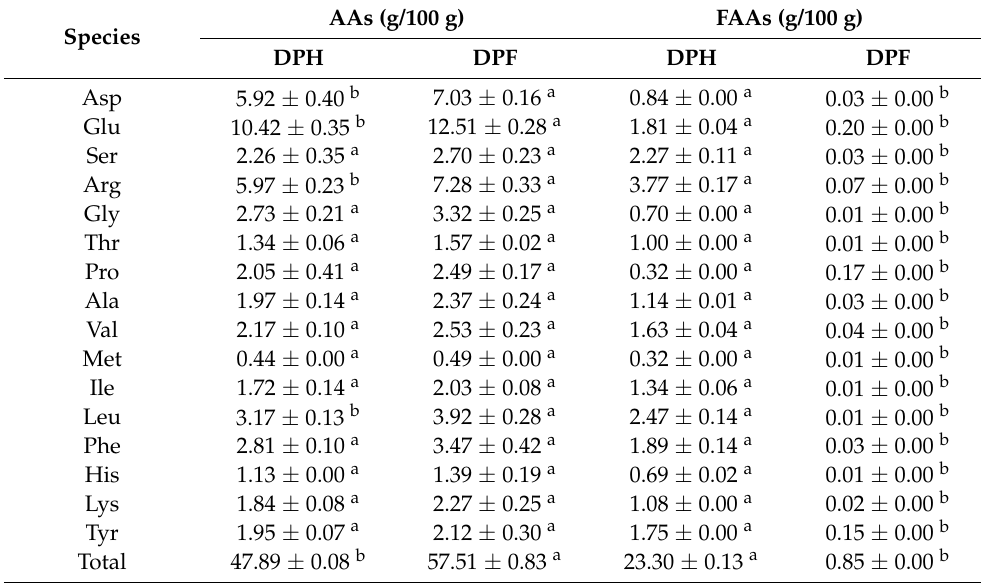
Table 1. AA compositions and FAA